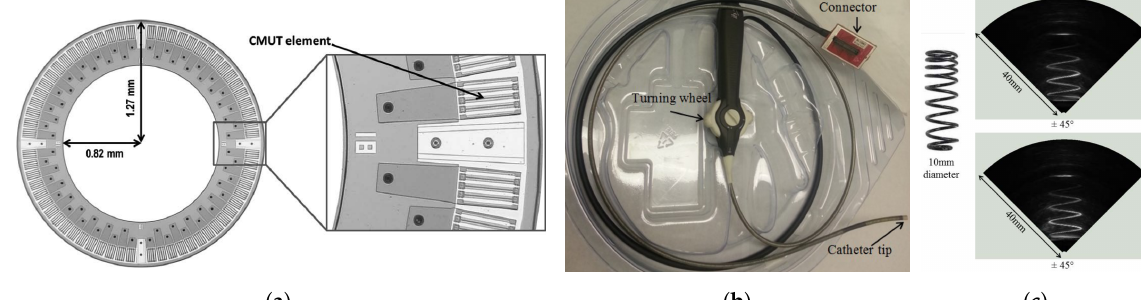
Figure 17. ( a ) CMUT ring array. ( b ) CMUT ring array integrated into a endoscopic assembly. ( c ) 3D imaging results of a spring. Images from [24]. Reproduced with permission from Moini, A. et al., 2016